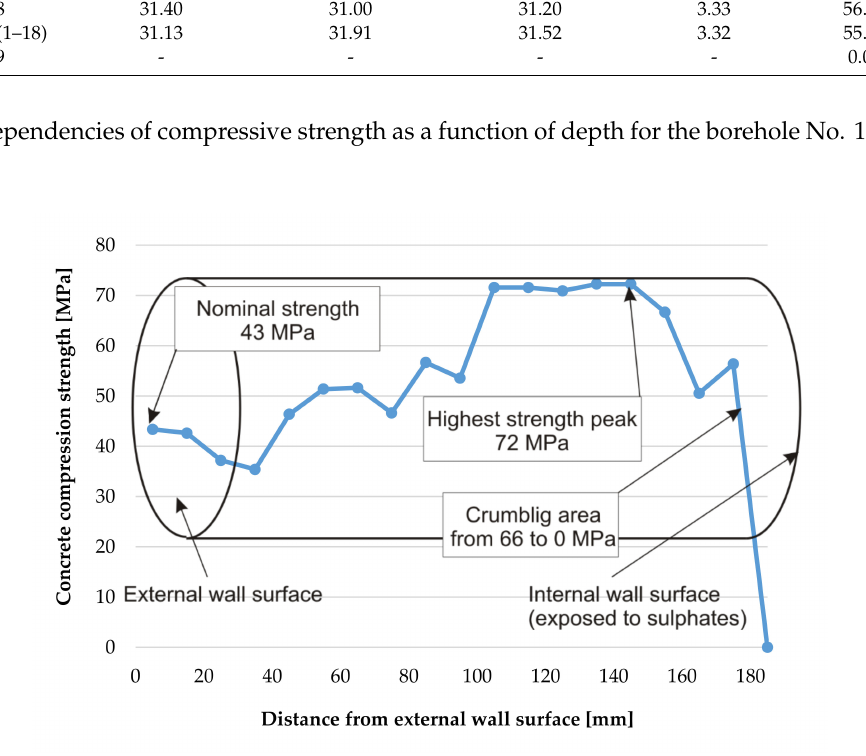
Figure 8. Change of concrete strength across the tank wall thickness in borehole No.